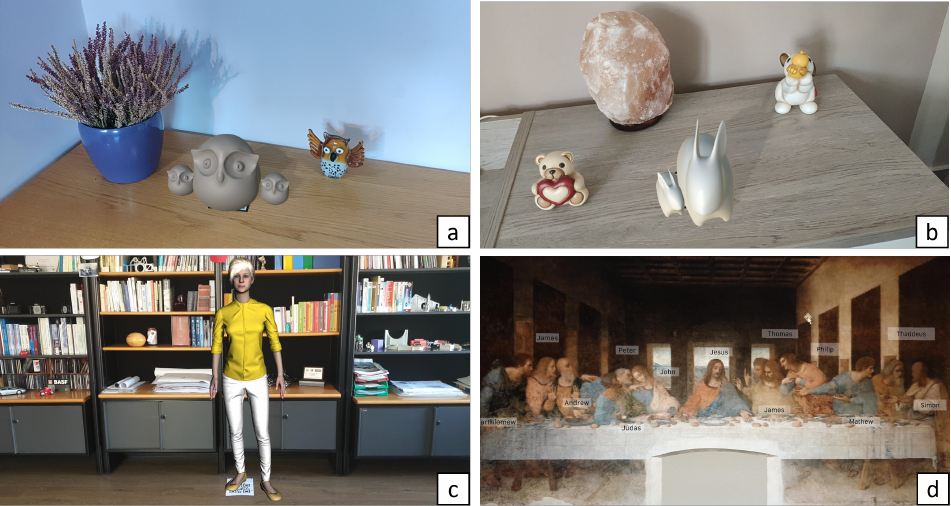
Figure 4. Case studies adopted for the evaluation of the proposed recoloring method: ( a , b ) porcelain design objects, ( c ) human avatar, and ( d )